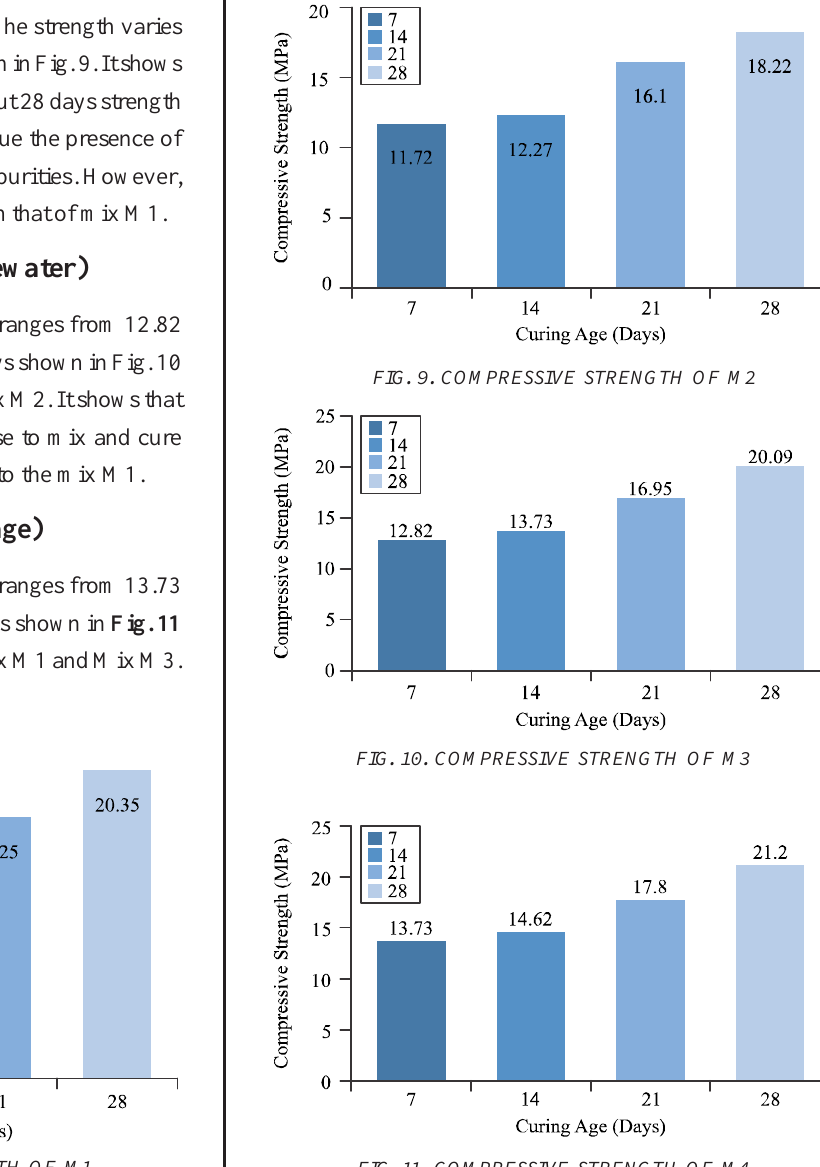
FIG. 11. COMPRESSIVE STRENGTH OF